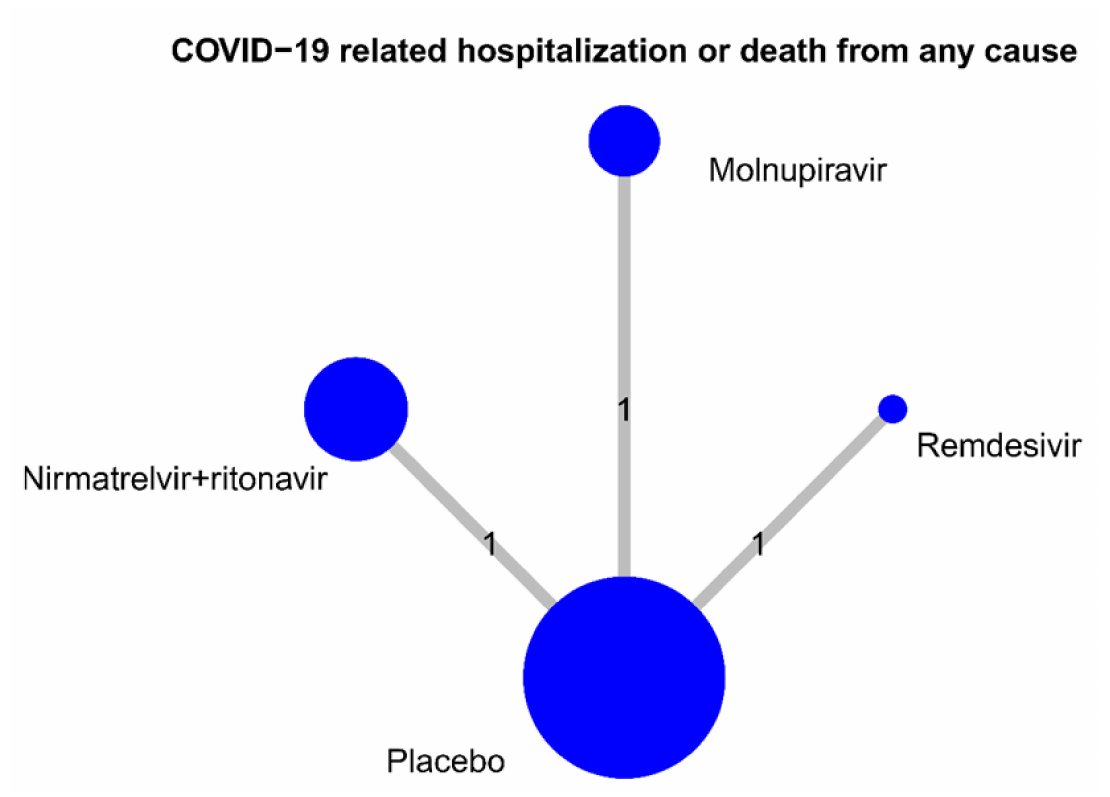
Figure 5. Number of studies for pairwise of antiviral drugs. The size of circle is proportional to sample size of each drug.